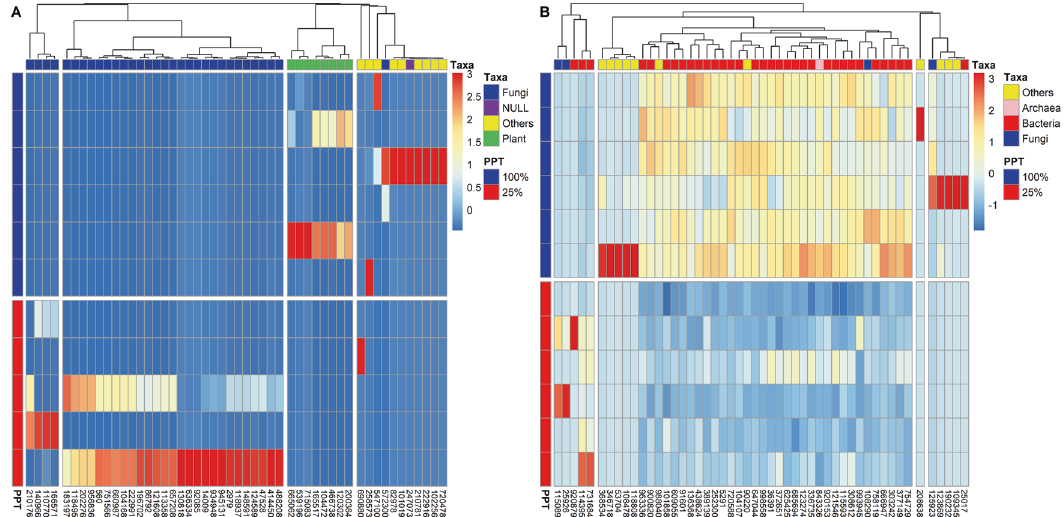
Fig. 5 Heatmap for top DA transcripts. Heatmaps for the top 50 most differentially abundant transcripts for ( A ) roots and ( B ) rhizosphere P -values belonged to the Proteobacteria , mainly the Alpha - and Delta - classes (Table 2 and Fig. 5B). Many of the most signi fi cantly less abundant transcripts in the 25% precipitation treatment were linked to the COG categories “ Cell motility and secretion ” and “ Intracellular traf fi cking and secretion ” , with functions related to pilus, fl agella and type II and VI secretion systems (Table 2). Similar